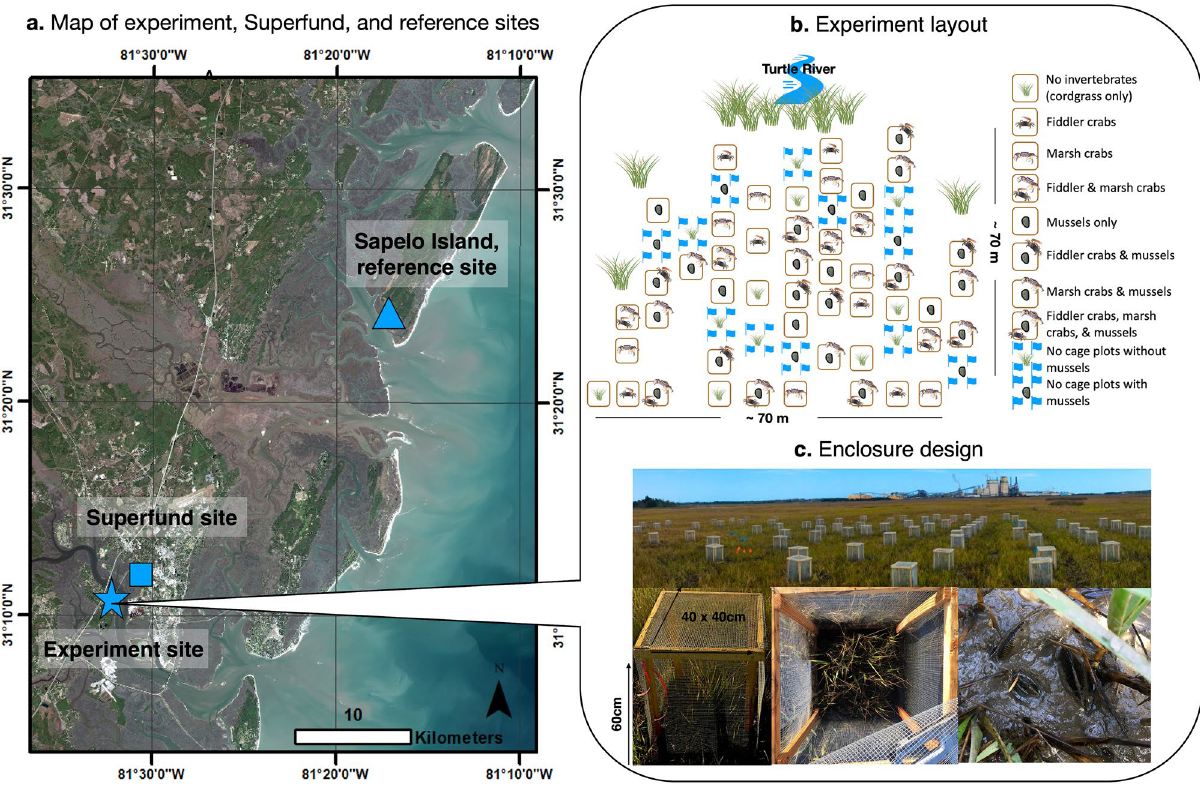
Figure 1. Sampling location and experimental design details. Location of experimental site on Blythe Island (blue star) in relation to the Superfund (blue square box) and reference site (blue triangle) ( a ). One of ten treatments, shown in the legend ( b ), was randomly assigned to each experimental enclosure ( c ). Icons were obtained through the integration and application network or Google Images (labeled for reuse with modification), the remaining images were photographed by K. Prince. Map was generated using ArcMap 10.7: https:// deskt op. arcgis. com/ en/ arcmap/ 10.7/ get- start ed/ setup/ arcgis- deskt op- quick- start- guide.